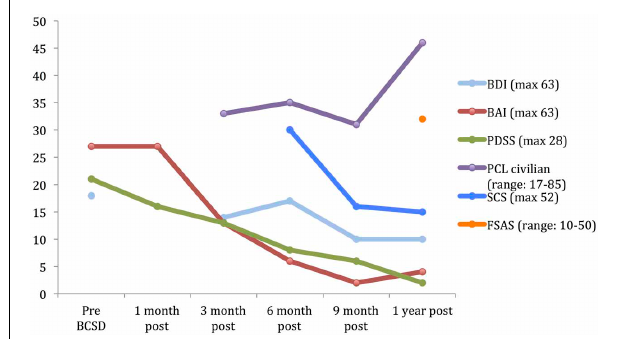
FIGURE 1 | Time course of psychiatric symptom rating for case 1 during 1 year follow up. BDI, Beck depression Inventory; BAI, Beck Anxiety Inventory; PDSS, panic Disorder Severity Scale; PCL, PTSD Check list; SCS, Shock Catastrophizing Scale; FSAS, Florida Shock Anxiety Scale. Note the increase in reported PTSD symptoms (via PCL civilian) at 1-year anniversary of worst shock episode, accompained by a moderate score on